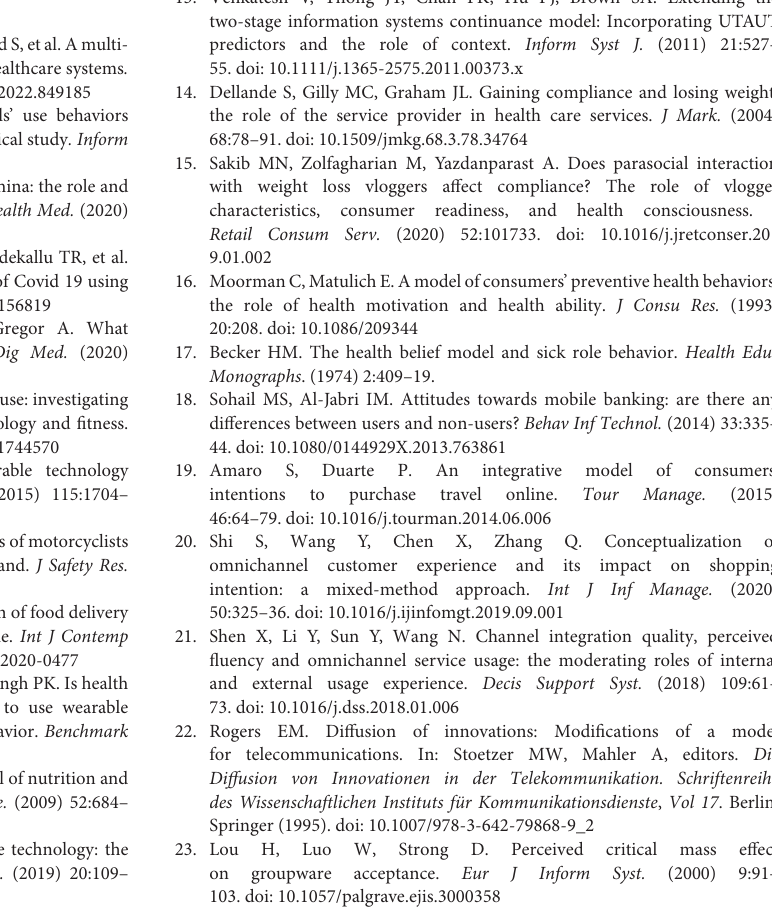
Supplementary Table 1 | Data file - Predicting the mass adoption of eDoctor